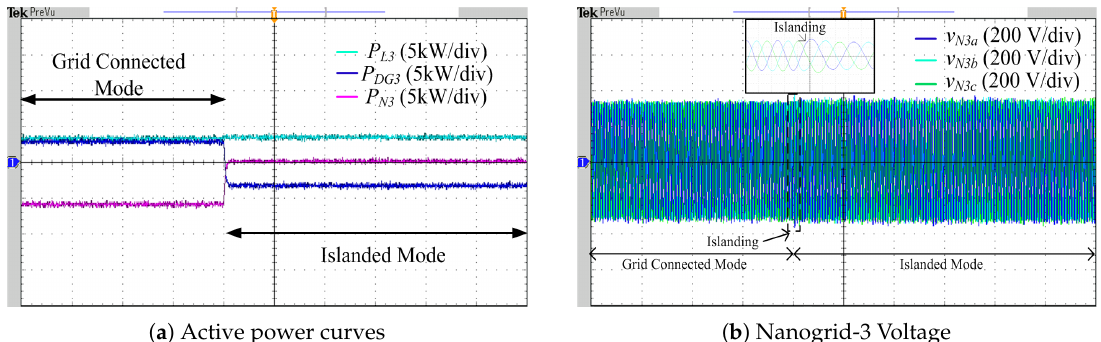
Figure 9. Transition of nanogrid-3 during grid connected to islanded operating